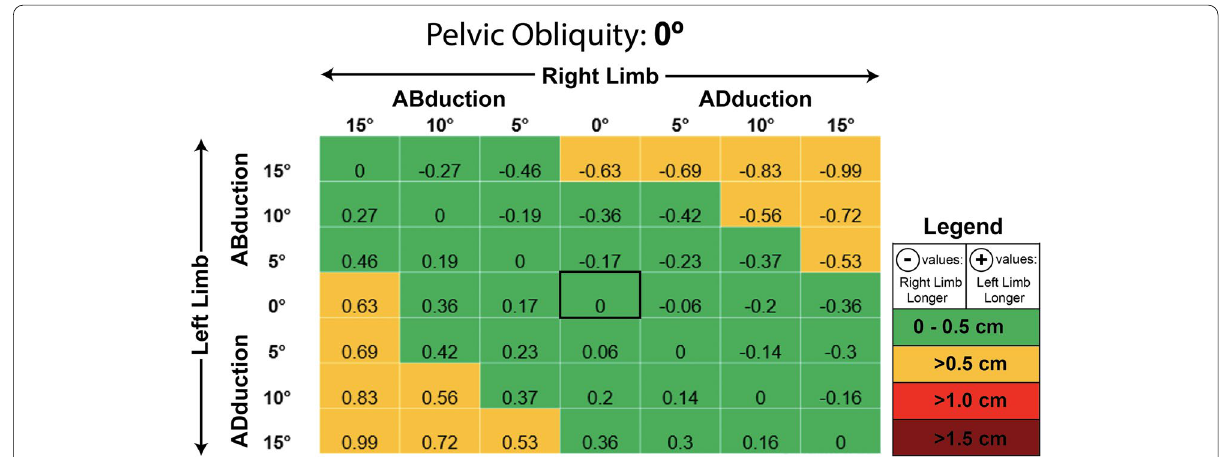
Fig. 4 Measurement error in centimeters seen at varying limb positions when the pelvic is set to 0 degrees of lateral obliquity (level pelvis in neutral position)